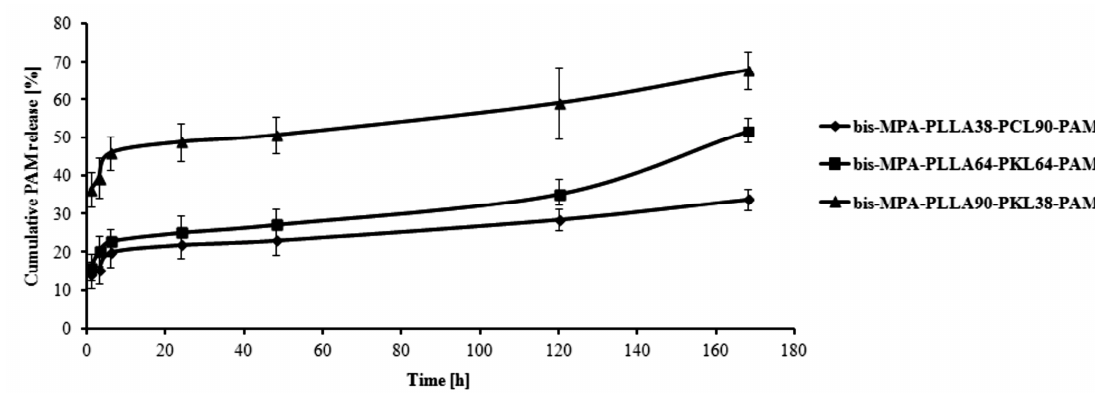
Figure 3. Release profile of PAM from the synthesized branched conjugates.